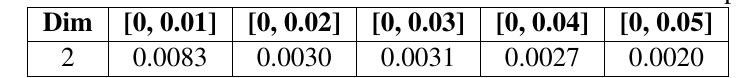
Table 6: Results on Scha ff er’s f6 function under the 2-dimensional space